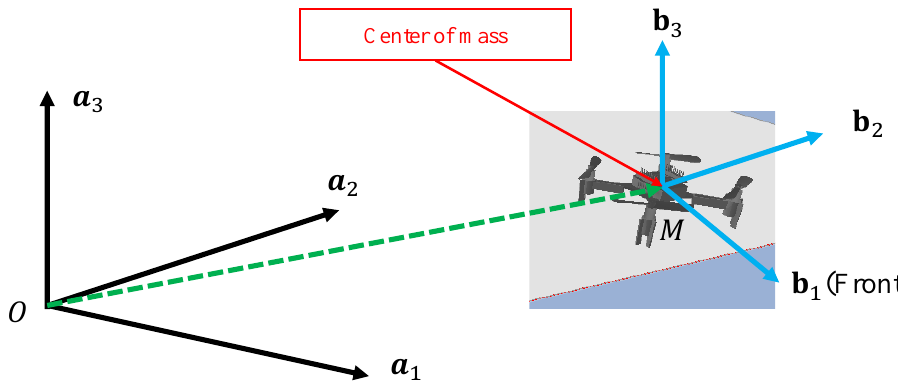
Figure 1. The description of the inertial frame A with triad a 1 , a 2 , and a 3 and the body frame B with triad b 1 , b 2 , and b 3 . The position [ x , y , z ] is the vector from O to M